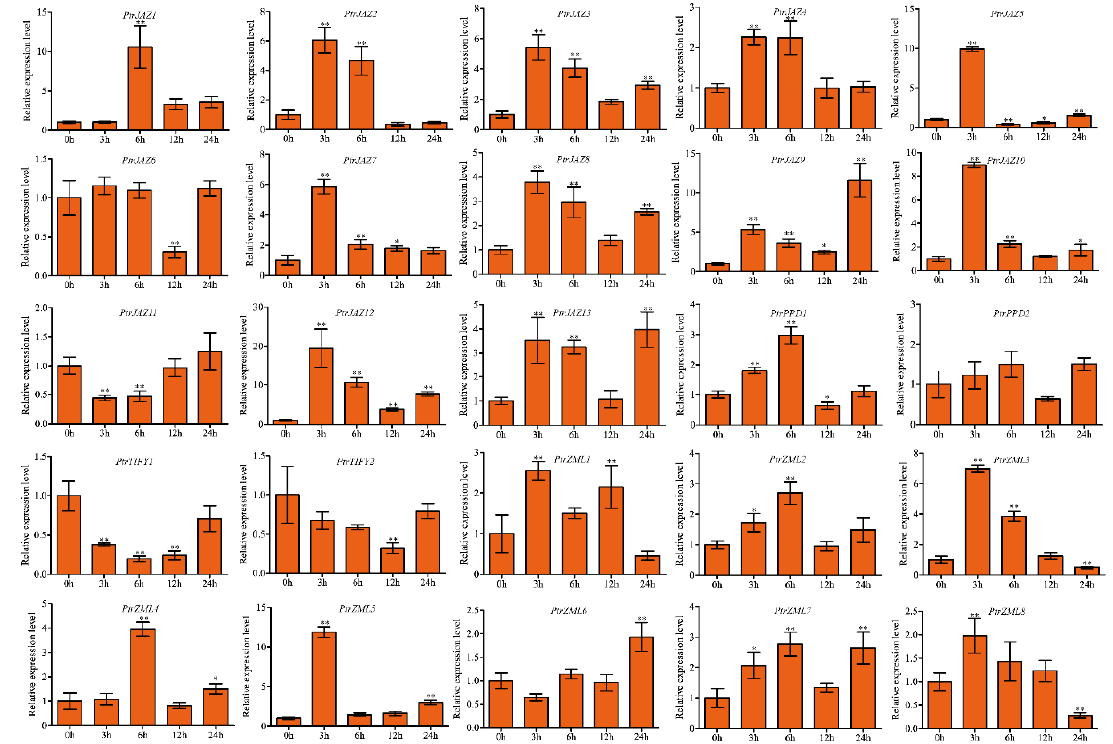
Figure 6. Expression analysis of PtrTIFY genes in root under low-temperature stress by qRT–PCR. Error bars represent the standard deviations from three biological replicates. Asterisks indicate stress treatment groups that showed a significant di ff erence in transcript abundance compared with the control group (* p < 0.05, ** p <